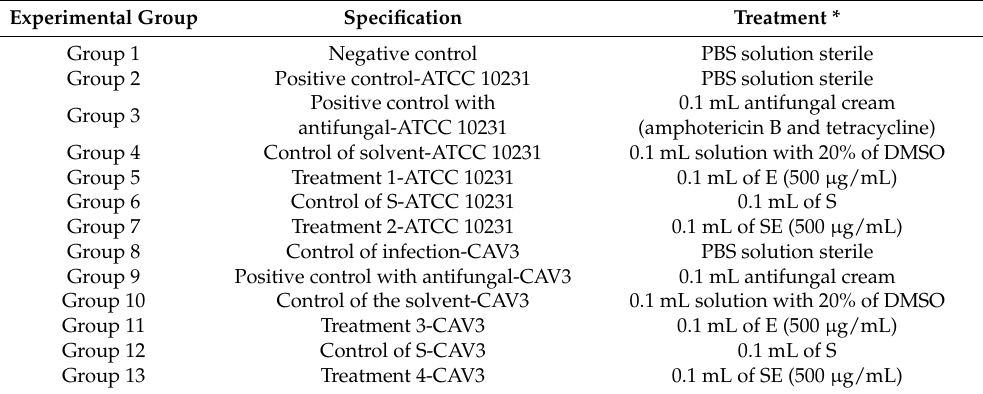
Table 8. Experimental groups of in vivo treatment assay of vulvovaginal candidiasis (VVC). Experimental